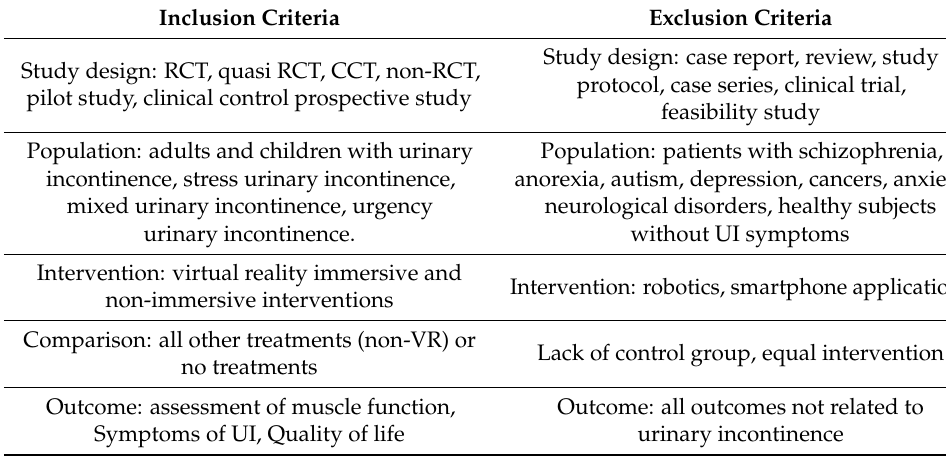
Table 1. Inclusion and exclusion